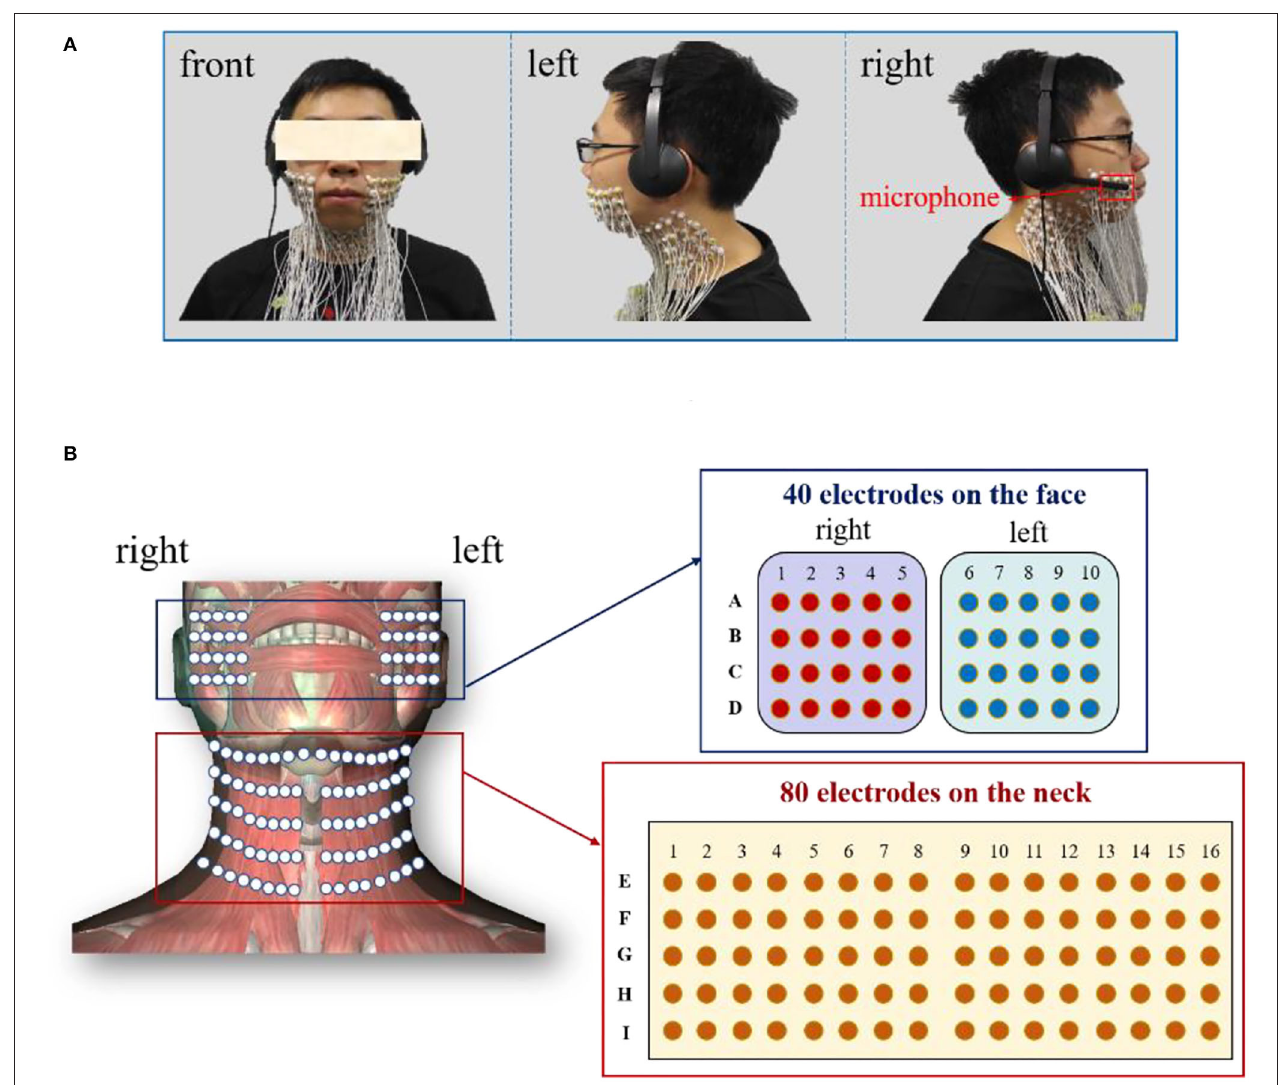
FIGURE 1 | (A) Experimental setup to record the speech and HD sEMG signals simultaneously; (B) Placement of the high-density surface electrodes on the facial and neck